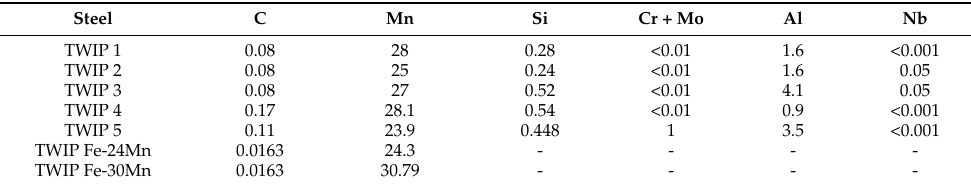
Table 11. Chemical composition of TWIP steels, wt%. Data from [37].